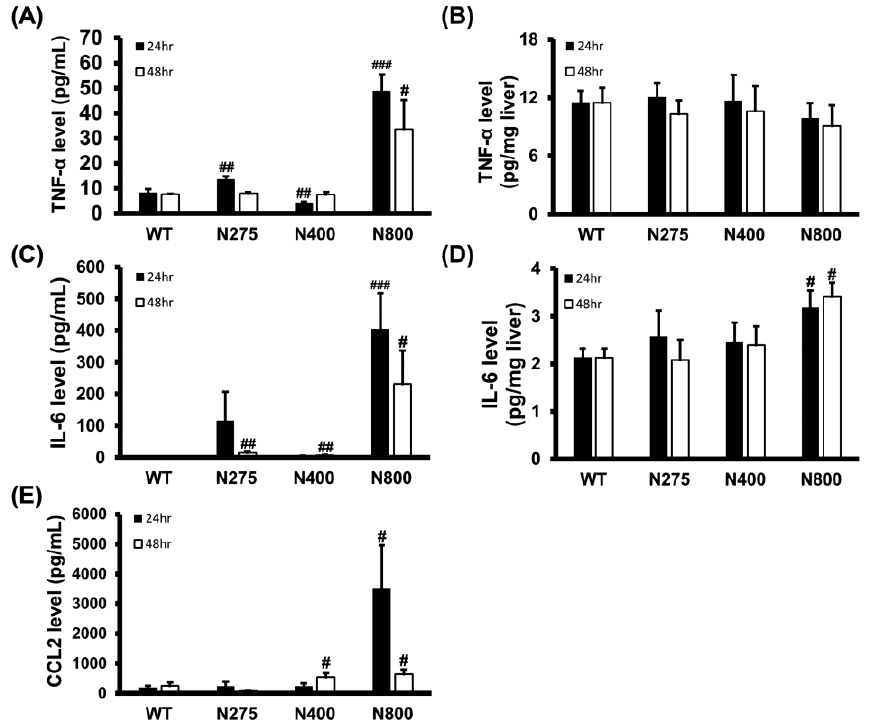
Figure 7. Effects of different doses of NAC administered to BALB/c mice on serum ( A , C , E ) and hepatic ( B , D ) levels of TNF-α ( A , B ), IL-6 ( C , D ), and CCL2 ( E ) at 24 h and 48 h post-NAC injection. Significant differences compared with the WT group are indicated by # (p < 0.05), ## (p < 0.01), and ### (p < 0.001).